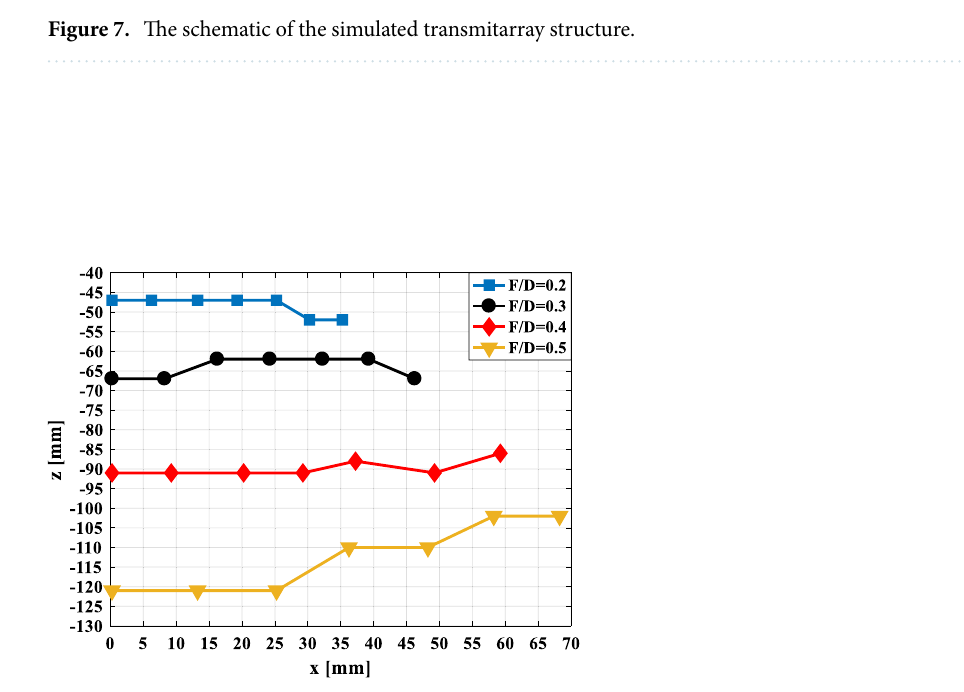
Figure 8. The focused spot locations for four values of F / D = 0.2, 0.3, 0.4, 0.5 , in different incident